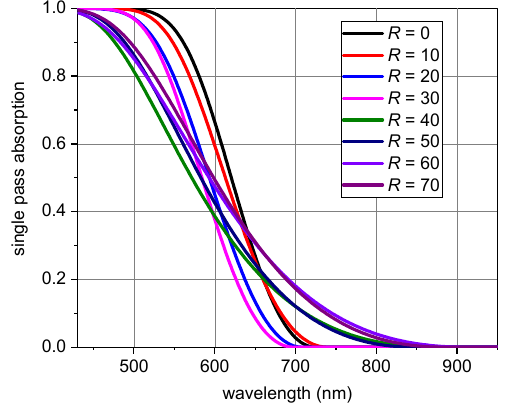
Figure 3. Normalized single pass absorption.